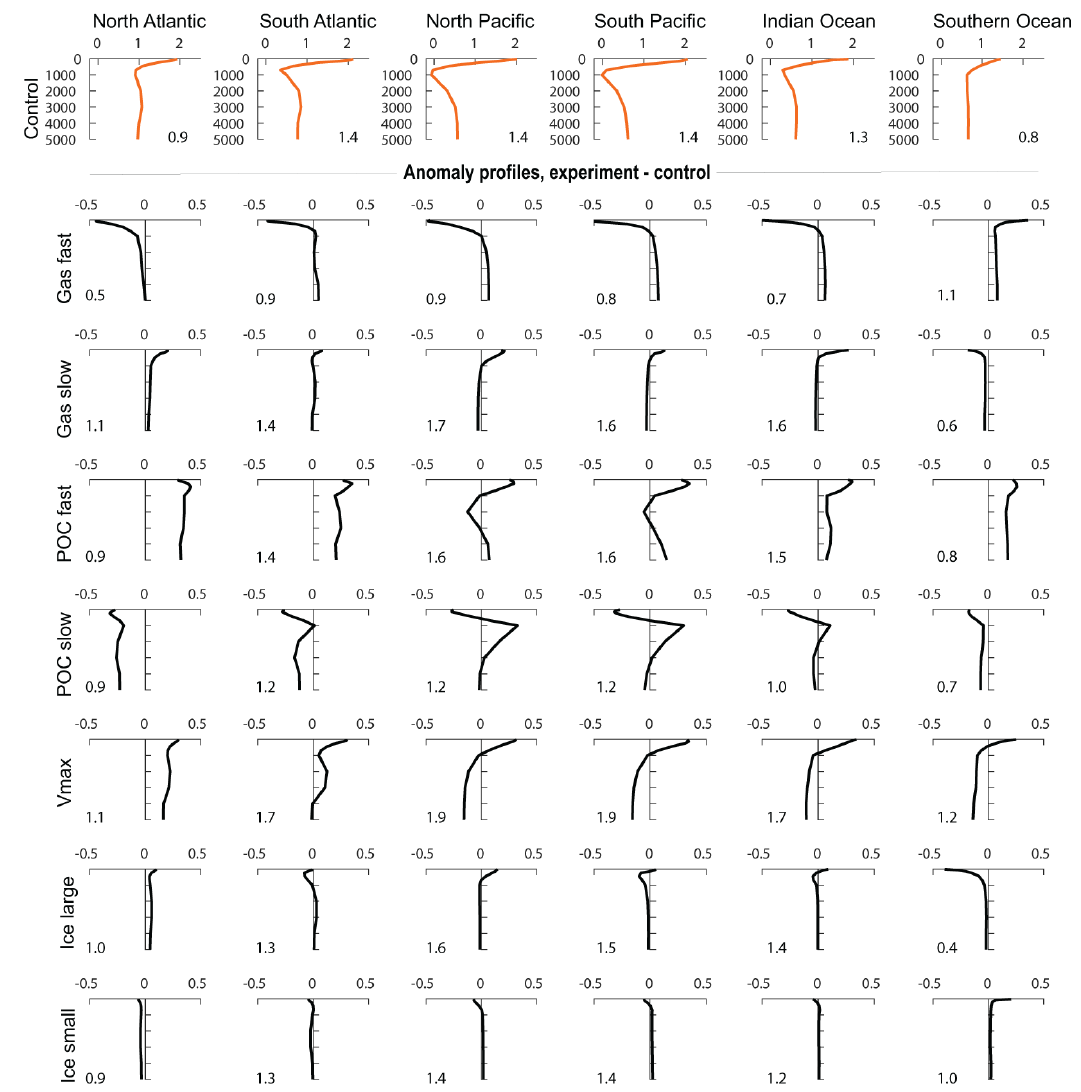
Figure 4. Volume-weighted basin mean anomaly profiles of δ 13 C after 2000 years, with respect to the control profiles (upper row). (cid:49)δ 13 C denoted per basin in the lower right (control) and lower left (sensitivity experiments) corner of each subgraph. Results are presented for the global gas exchange and POC sinking experiments. Basin extent is visualised in Fig.